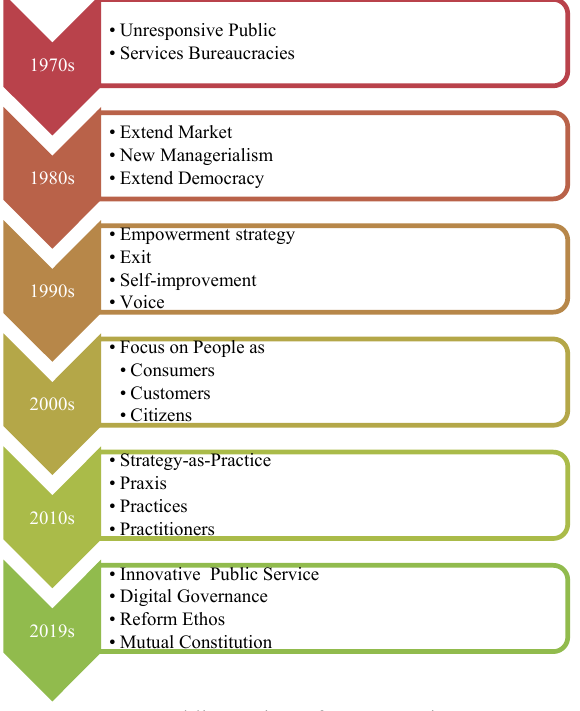
Fig . 3 . Public service reform